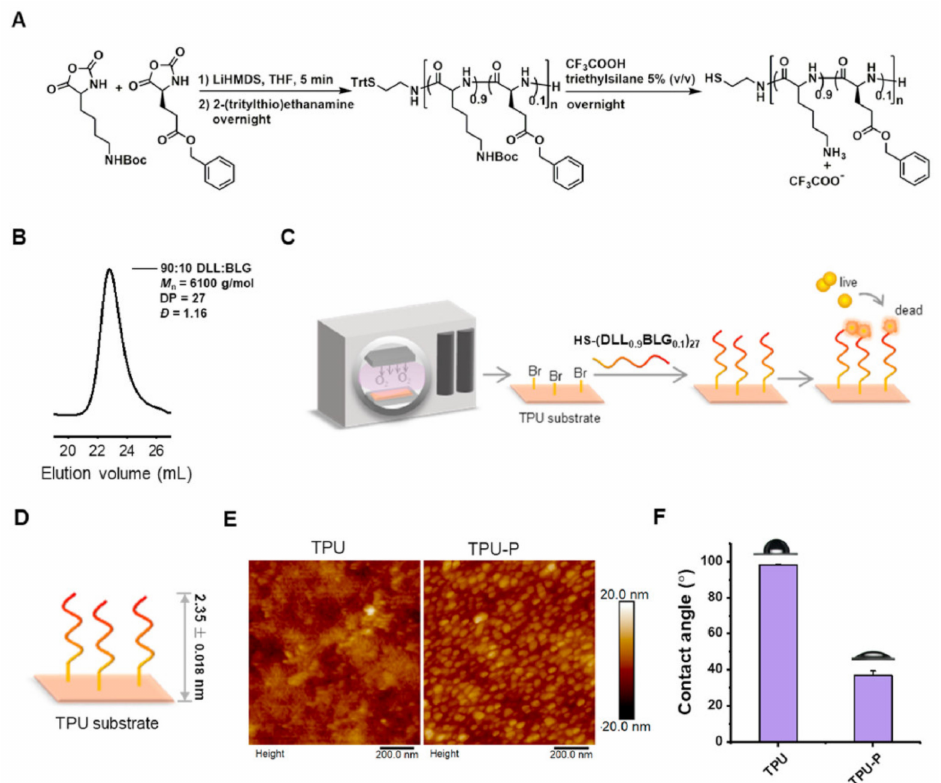
Figure 5. Preparation and analyses of the peptide modified TPU surface. ( A ) Synthesis of the polymer, ( B ) characteristics of the peptide polymer, ( C ) modification of the polymer surface, ( D ) thickness of the peptide layer on the TPU-substrate, ( E ) atomic force microscopic pictures of the TPU and peptide modified TPU surface, ( F ) water contact angles of the two different surfaces. Reproduced from Ref.